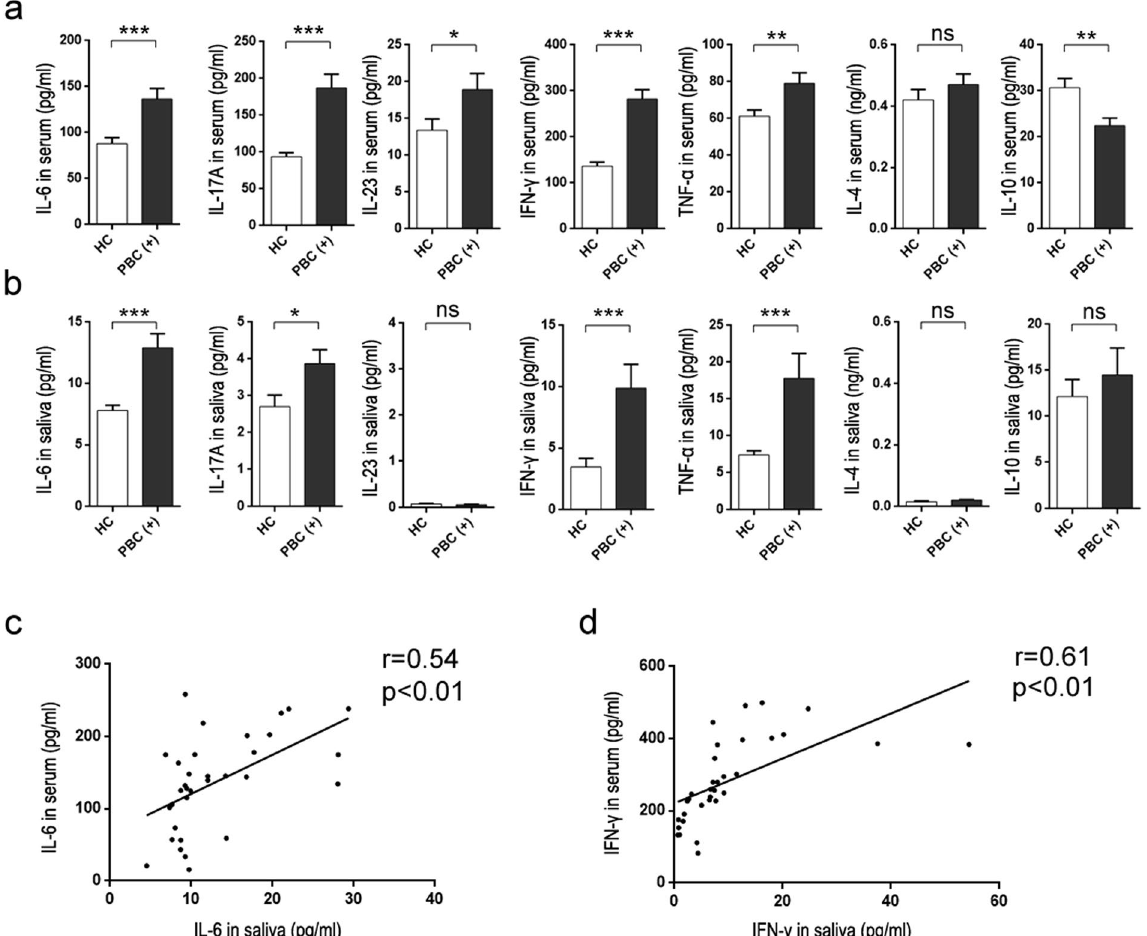
Figure 4. Inflammatory cytokine levels in serum and saliva of PBC patients. The levels of IL-6, IL-17A, IFN- γ , TNF- α , IL-23, IL-4, and IL-10 in serum ( a ) and saliva ( b ) of HCs (healthy controls, n = 60) and PBC patients (serum AMA-M2-positive PBC patients, n = 33) were determined using Luminex Bead Assay. Data presented are the means ± SEM. ( c ) Correlation between salivary IL-6 and serum IL-6 levels in patients with PBC (serum AMA-M2-positive PBC patients, n = 33). ( d ) Correlation between salivary IFN- γ and serum IFN- γ levels in patients with PBC (serum AMA-M2-positive PBC patients, n = 33). * P < 0.05; ** P < 0.01; *** P < 0.001; ns, not